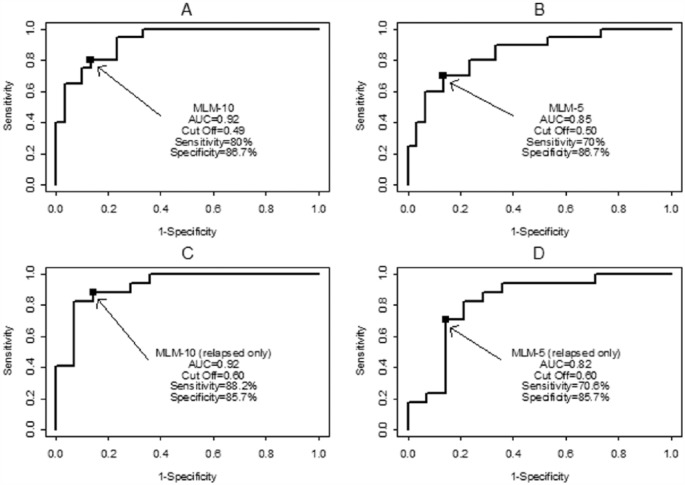
ROC curves using panels of 10 biomarkers (MLM-10) and 5 biomarkers (MLM-5), respectively. A) MLM-10, all patients; B) MLM-5, all patients; C) MLM-10, relapse only; D) MLM-5 relapse only. ROC indicates receiver operating characteristic. Arrows indicate Cut Off values.